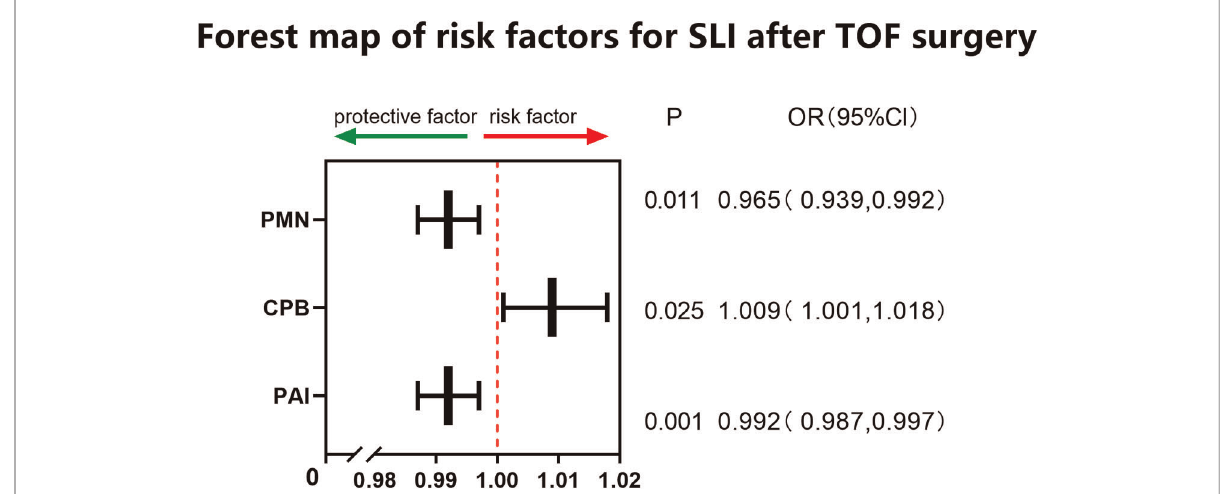
FIGURE 1 Correlation between Postoperative P/F and PAI. PAI, pulmonary artery index.